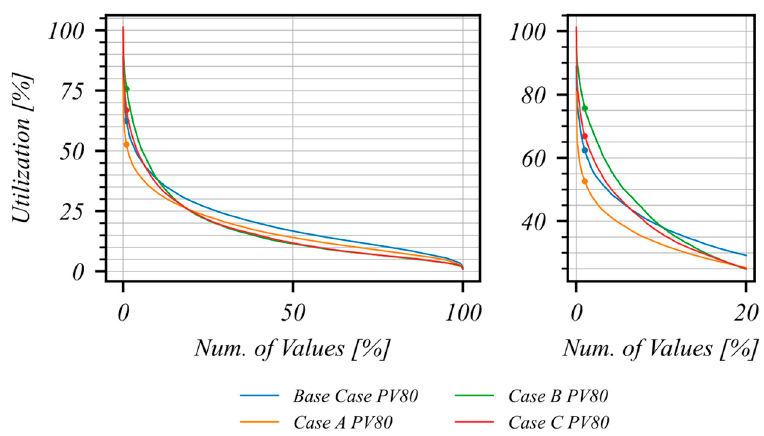
Figure 9. Impact of the demand function on the mean transformer utilization.